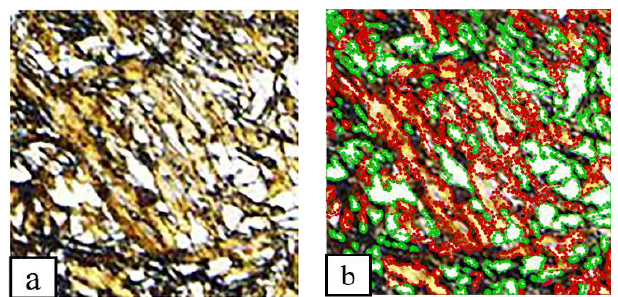
Figure 3. Manual labeling of microstructure pictures: ( a ) original picture; ( b ) manually marked picture (red marked as lath martensite, green marked as retained austenite, black (not marked) as acicular martensite).